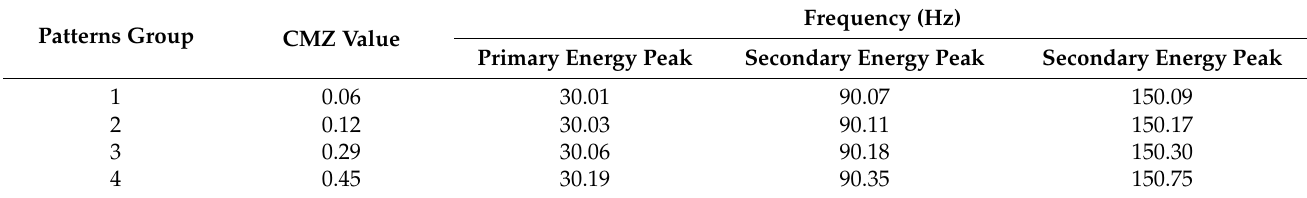
Table 3. Frequency results comparison of different pattern groups.